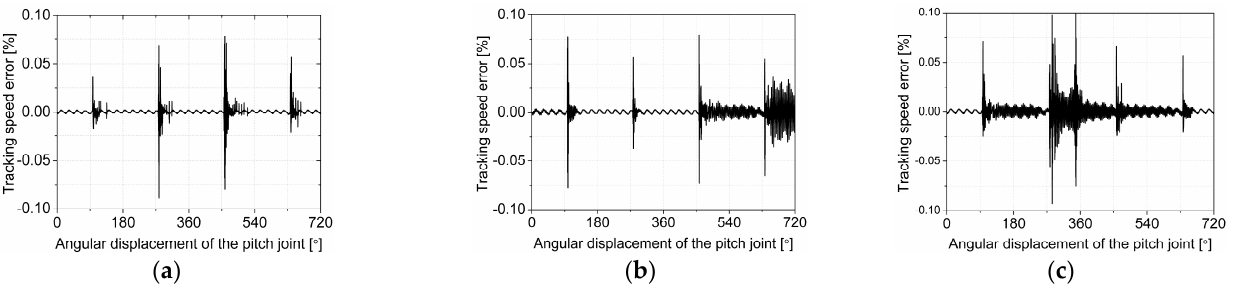
Figure 13. Tracking speed error of antenna reflector caused by different clearance size of planetary gear in pitch joint: ( a ) c pp = 100 μ m, b psp = b prp = 100 μ m; ( b ) c pp = 100 μ m, b psp = b prp = 10 μ m; and ( c ) c pp = 10 μ m, b psp = b prp = 100 μ m.